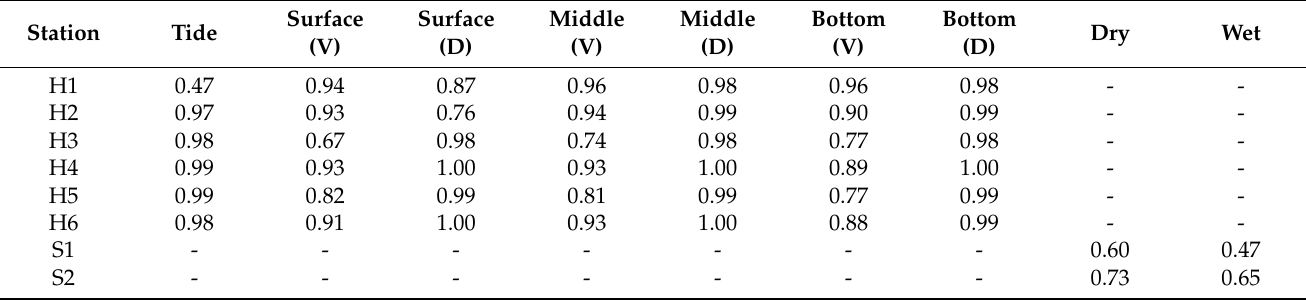
Figure 8. Verification of salinity in the dry ( left ) and wet ( right ) period. Table 2. Correlation coefficients ( r ) between simulation and measured values.